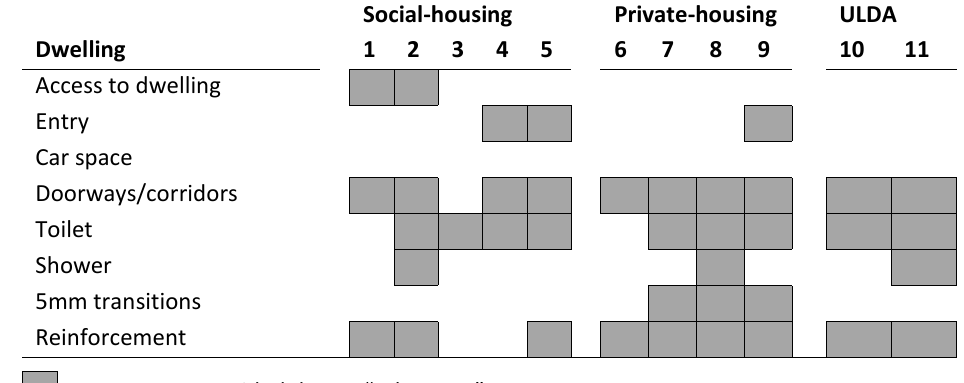
Table 3. Non-compliant features due to “otherness”